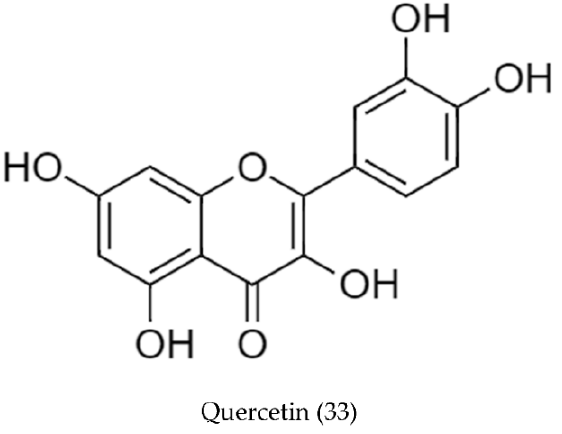
Figure 19. Chemical structures of quercetin.